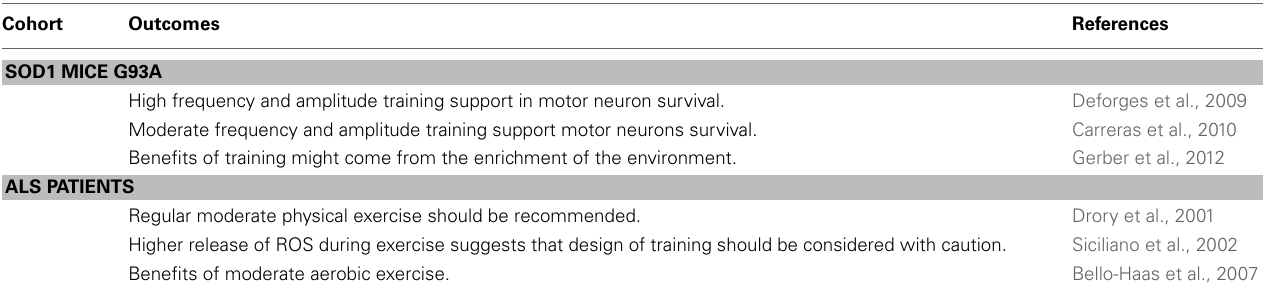
Table 3 | Effect of exercise in